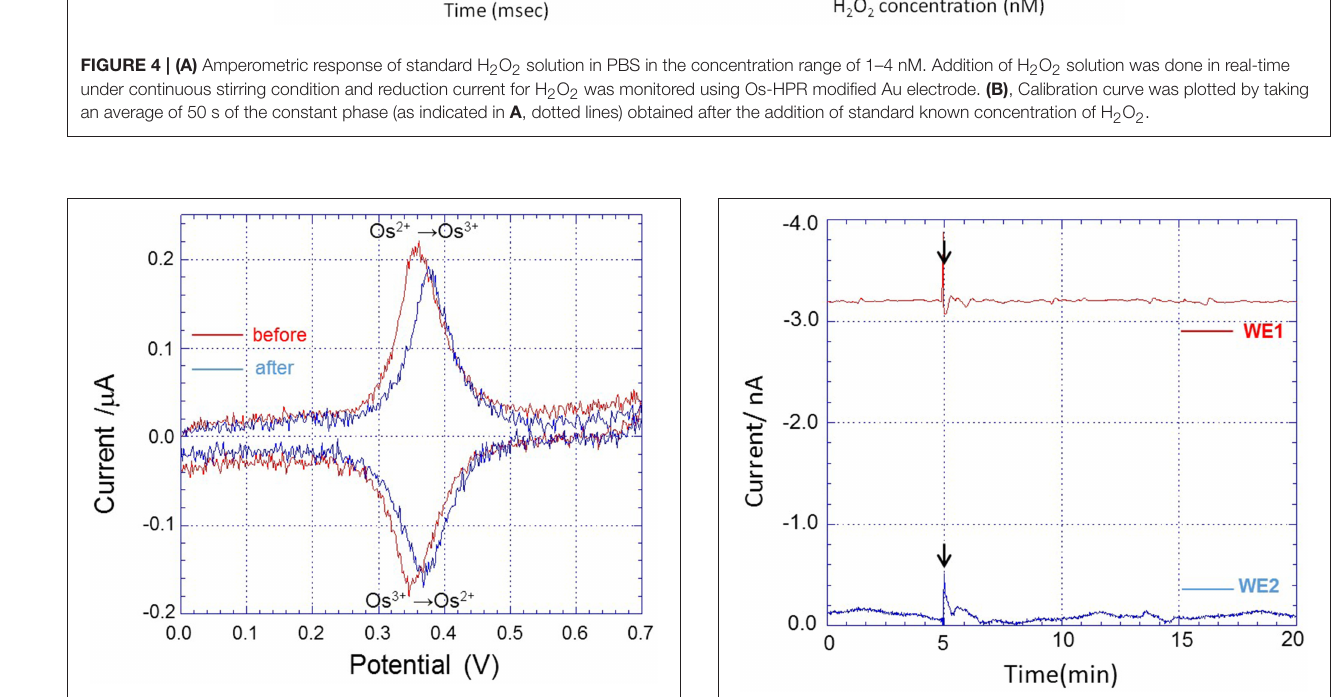
FIGURE 5 | Cyclic voltammogram of Os-HRP modified Au electrode conducted at a scan rate of 20 mV/s from 0.0 to + 0.7 V at room temperature before (red trace) and after 3 h of incubation in 10 µ M H 2 O 2 (blue trace).